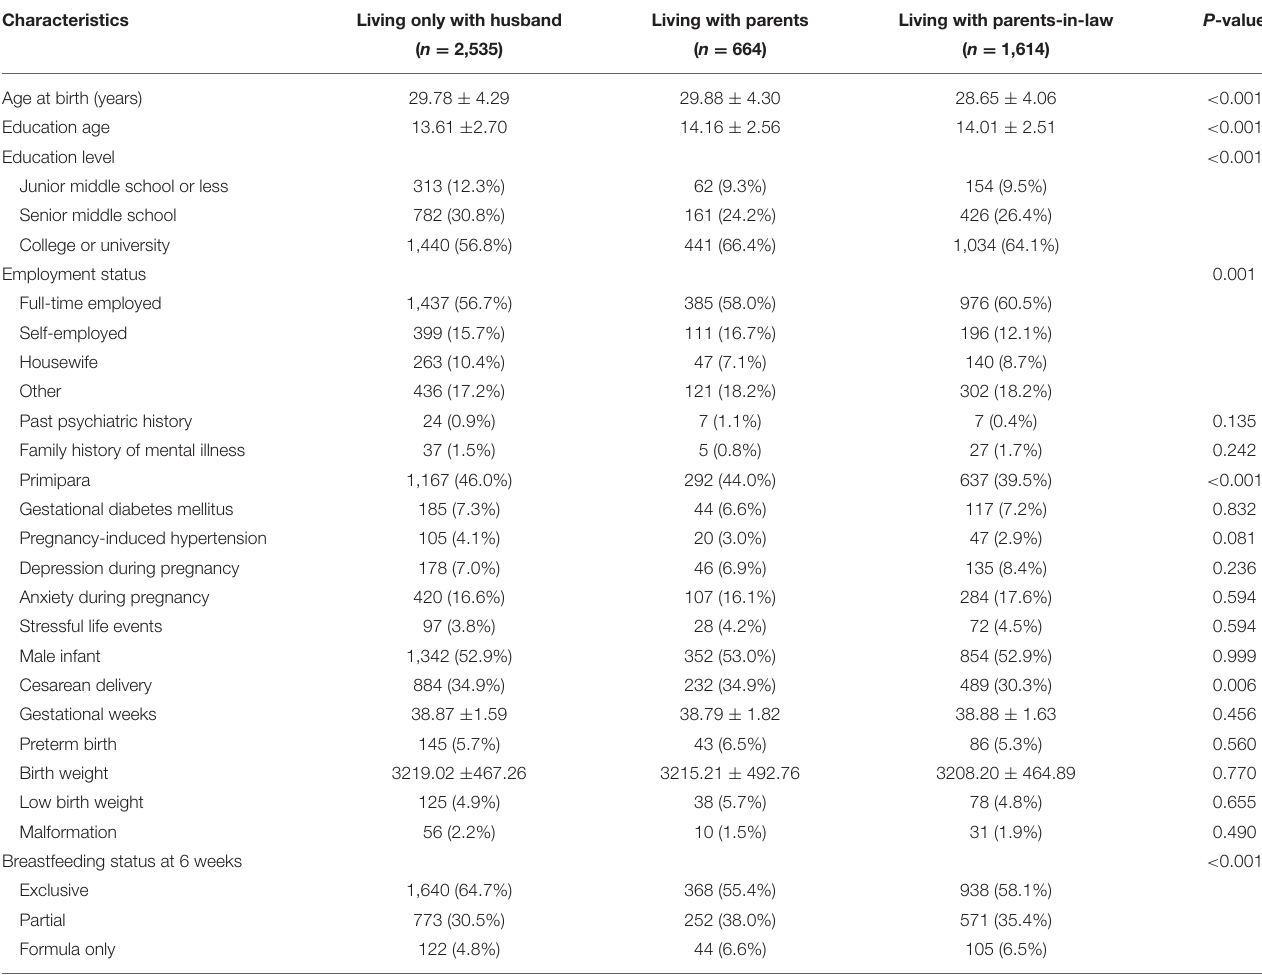
TABLE 1 | Social-demographic characteristics according to PPD status of women. Characteristics